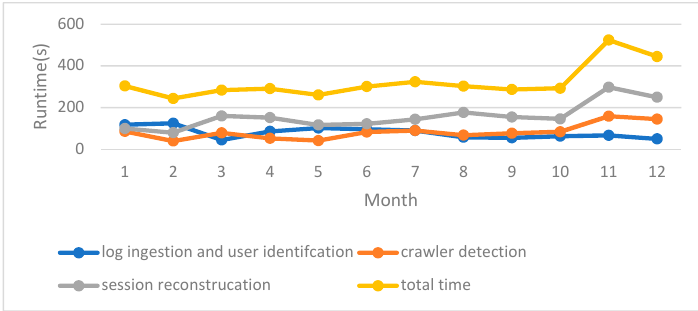
Figure 13. The stage processing time of logs in 2014 without the proposed framework.